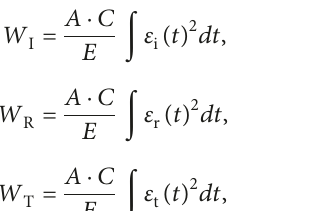
Figure 13: Crack distribution for rocks under different impact